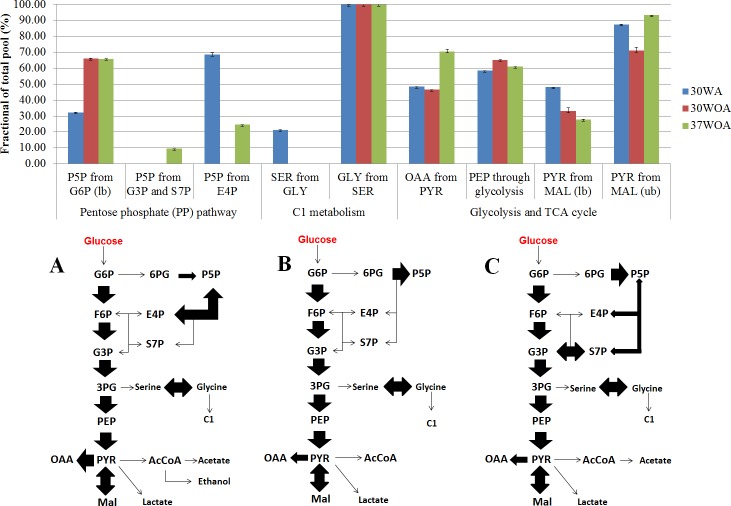
Simplified network models of L. lactis grown at different conditions.(A) The flux ratios visualized in bar chart was calculated using Fiatflux. The experimental error (error bars) was estimated from redundant mass distributions using FiatFlux. (B) Simplified flux map that describes the central carbon metabolism of L. lactis when grown at 30 °C with agitation (30WA), 30 °C without agitation (30WOA) and 37 °C without agitation (37WOA). Each flux map includes the reactions of the glycolysis, the oxidative and non-oxidative pentose phosphate (PP) pathways, as well as the reactions catalyzed by pyruvate carboxylase, malic enzyme and serine and C1 metabolism. Fermentation by-products of lactate, acetate and ethanol were also included in the flux map. Abbreviation; G6P, glucose-6-phosphate; F6P, fructose-6phosphate; G3P, glyceraldehyde-3-phosphate; P5P, ribose-5-phosphate; S7P, sedoheptulose-7-phosphate; E4P, erythrose-4-phosphate; 3PG, 3-phosphoglyceric acid; PEP, phosphoenolpyruvate; pyruvate, PYR; oxaloacetate, OAA; malic acid, Mal; acetyl-CoA, AcCoA.